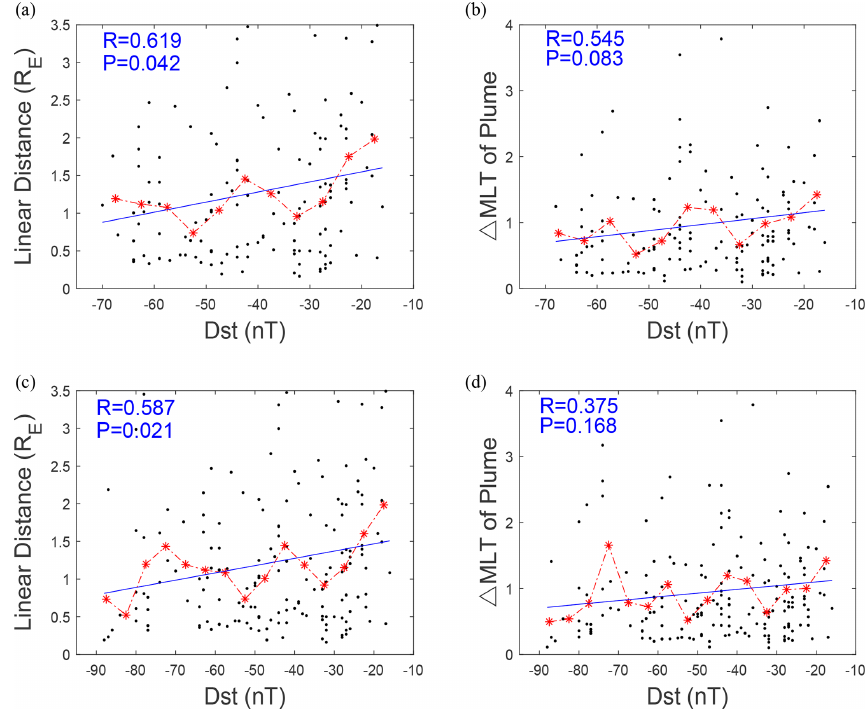
Figure 5. The format is the same as in Fig. 2. However, only the retained plume events that meet more stringent sifting conditions are analyzed.